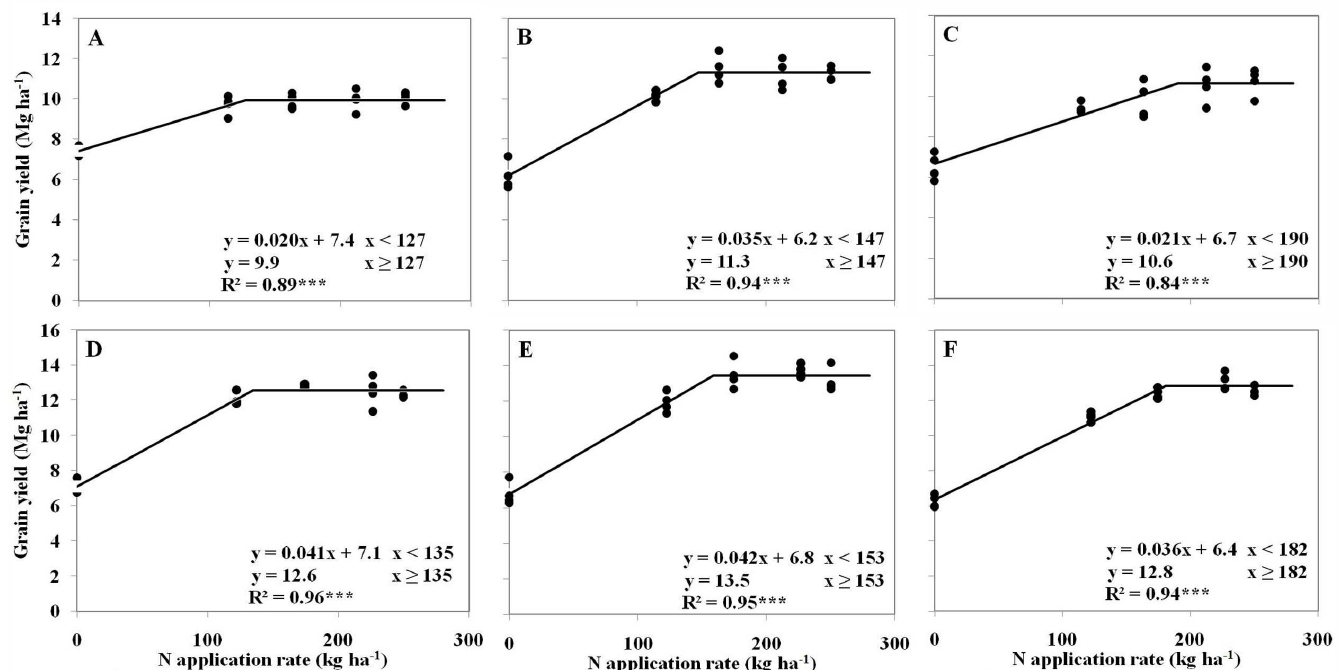
Fig 1. Maize grain yield as a function of N application rate for three plant densities during the two-year study. Plantingdensitieswere 6.0, 7.5, and 9.0 plant m –2 in 2013 in panels A–C, respectively, and were 6.0, 7.5, and 9.0 plant m –2 in 2014panels D–F, respectively.